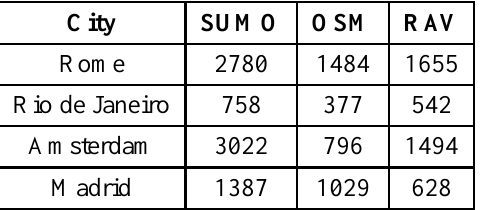
Table 6. Number of streets obtained depending on the criterion used.